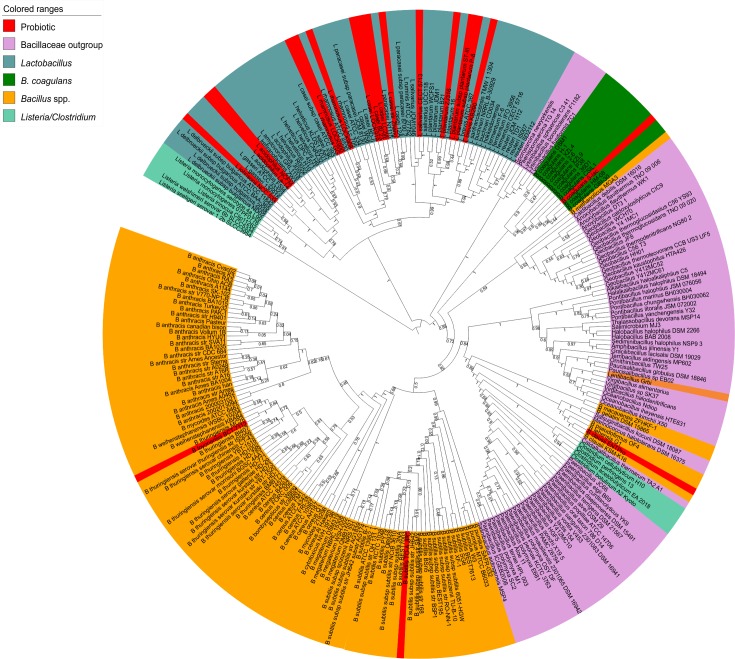
26 Housekeeping ML-based phylogenetic analysis of members of genus Bacillus, Lactobacillus, Clostridium and Listeria and other members of family Bacillaceae.The species have been colored according to the genus they belong to: Bacillus spp. are colored orange, outgroups of Bacillaceae family are colored dark-pink, outgroup members related to Clostridiaceae and Listeriaceae family are colored dark-blue, Lactobacillus spp. are colored blue. The organisms that have been used as probiotics are colored red.